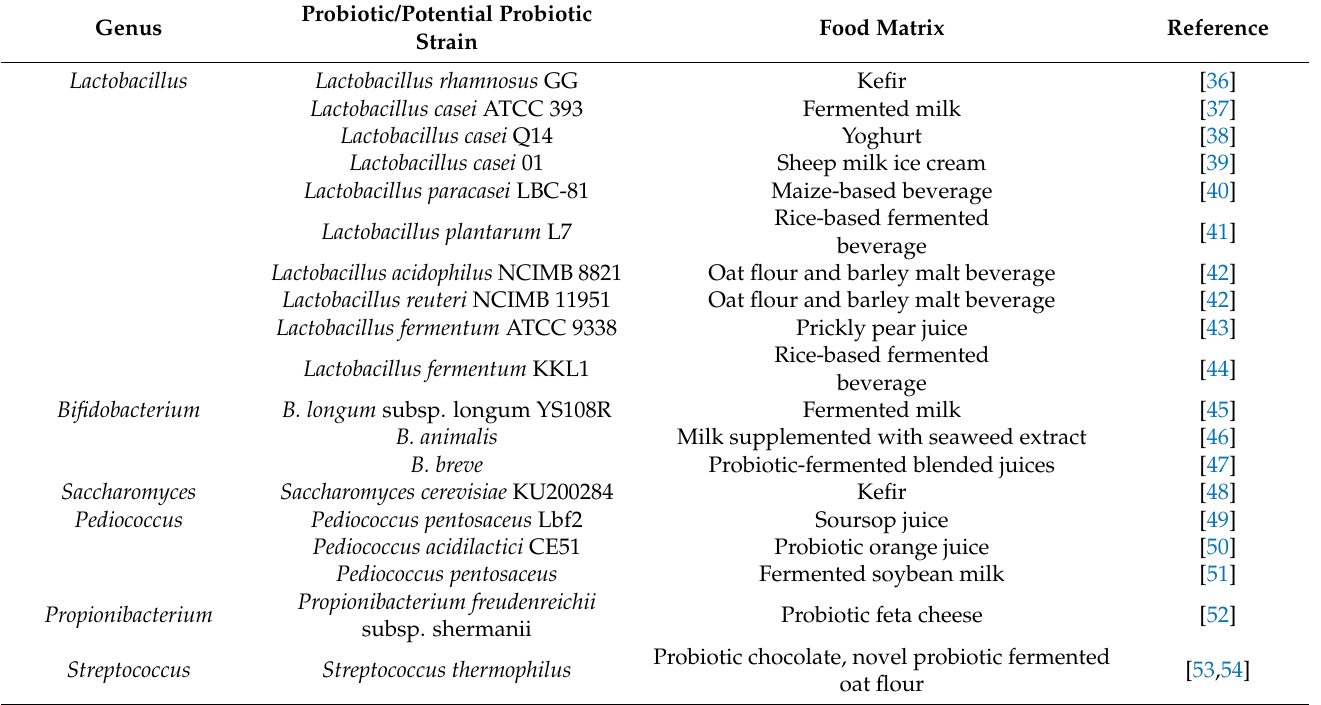
Table 1. Commonly used probiotics and beneficial microorganisms in dairy and non-dairy plant- based food